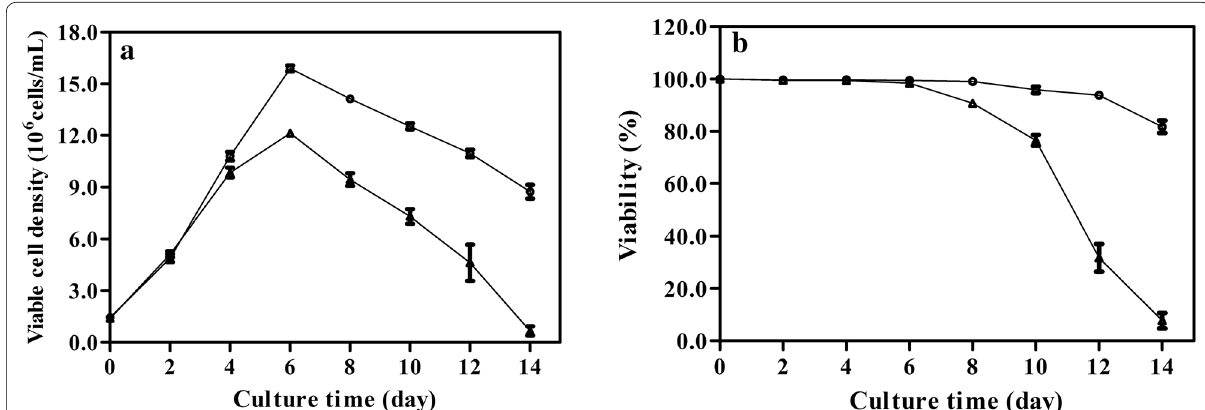
Fig. 1 Effects of addition of uridine on cell growth, and cell viability. a Viable cell density; b cell viability. Control cultures were performed without uridine feed (blank triangle); uridine was added to culture at a total concentration of 6 mM (blank circle). The error bars indicate the standard deviations from three independent